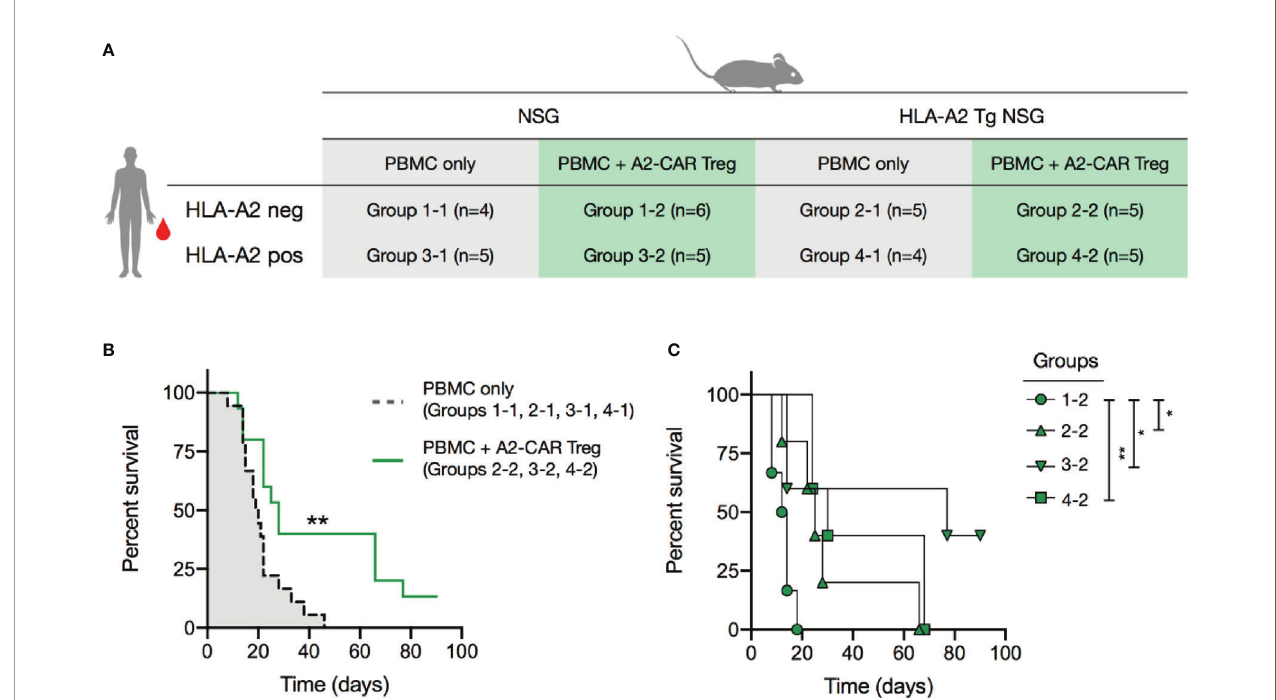
FIGURE 5 | A2-CAR Tregs confer protection against graft- versus -host disease. (A) 2.5 x 10 6 AAV CRISPR-edited A2-CAR + TCR de fi cient Tregs (generated as described in Figure 4 ) were co-injected with 5 x 10 6 A2 negative or positive PBMC in wild type or A2 transgenic immunode fi cient NSG mice. PBMCs and Tregs were injected into contralateral retro-orbital plexus. (B) Overall survival of mice that received PBMCs (A2 positive or negative, NSG A2 positive or negative) or PBMCs and A2-CAR + TCR de fi cient Tregs, excluding the condition where Tregs remained unstimulated (group 1-2). (C) Overall survival of mice treated with A2- CAR + TCR de fi cient Tregs comparing NSG PMBC (group 1.2, round), A2-NSG PBMC (group 2-2, triangle), NSG A2 + PBMC (group 3-2, inverted triangle, n=6), and A2-NSG A2 + PBMC (group 4-2, square). Log-rank (Mantel-Cox) test was used for statistical analysis * p < 0.05 , ** p <